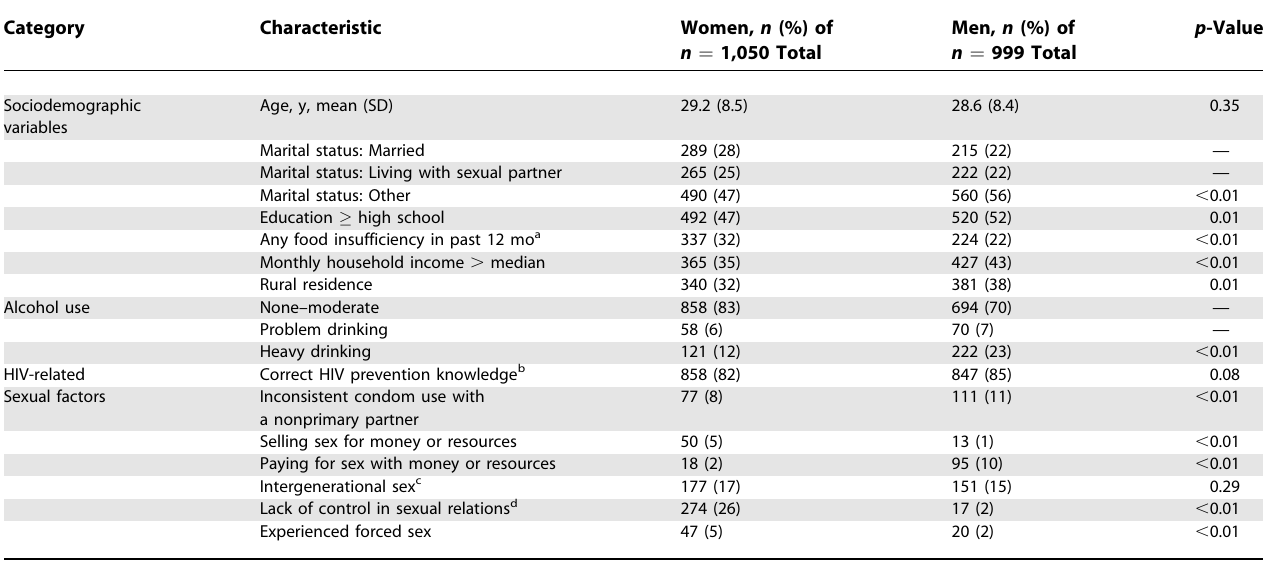
Table 1. Baseline Characteristics of Respondents, Botswana and Swaziland 2004–2005 Category Characteristic Women, n (%) of